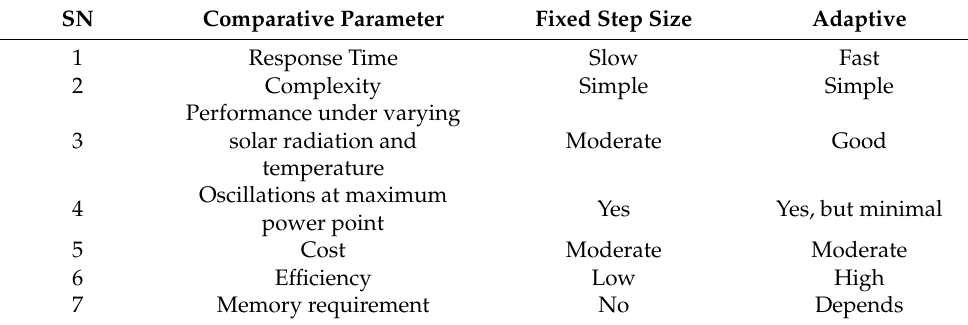
Table 2. Comparison of conventional P&O algorithms. SN Comparative Parameter Fixed Step Size Adaptive 1 Response Time Slow Fast Simple